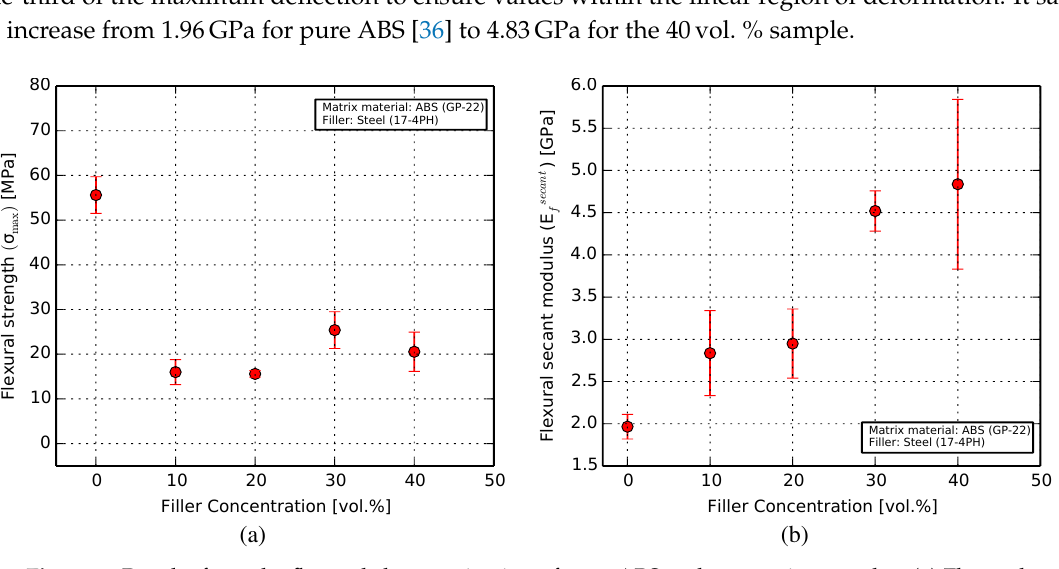
Figure 7. Results from the flexural characterization of pure ABS and composite samples: ( a ) Flexural strength showing a sharp decrease in flexibility due to the inclusion of filler particles; ( b ) The flexural secant modulus of elasticity increasing by over a factor of two for the composites, compared to pure